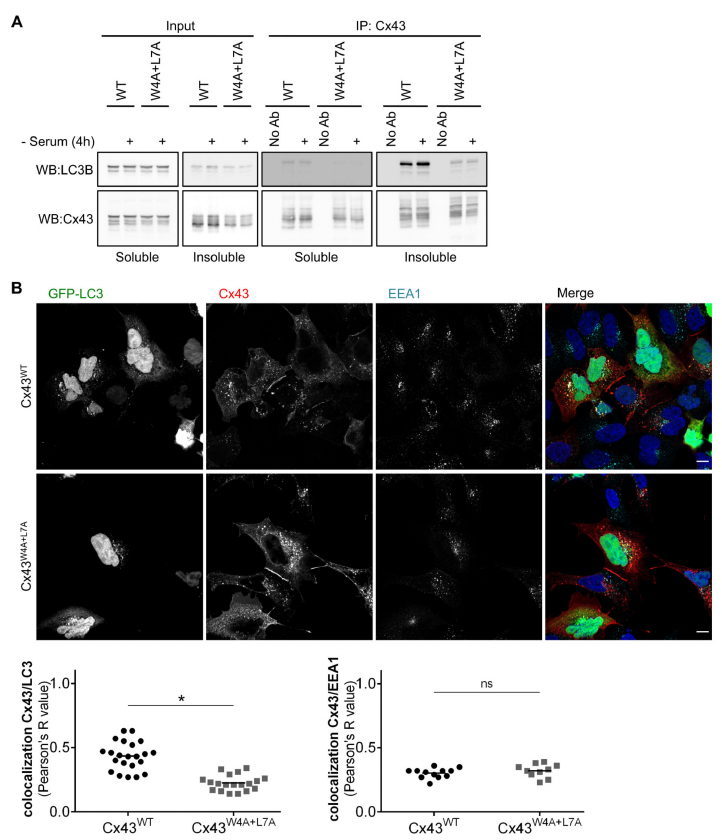
Figure 3. LC3B preferentially interacts with Cx43 present in post-endocytic vesicles. ( A ) HEK293A cells co-transfected with GFP-LC3B and wild type (WT) or mutant (W4A + L7A) Cx43 were incubated in medium without serum for 4 h (-Serum). Cell lysates were then separated into Triton X-100 soluble and insoluble fractions and immunoprecipitated with goat polyclonal antibodies directed against Cx43. Precipitates were then analysed using Western blot using rabbit polyclonal antibodies against Cx43 or LC3B. ( B ) HEK293A cells grown on coverslips were co-transfected with plasmids expressing GFP-LC3B and either Cx43 WT or Cx43 W4A + L7A . Subcellular distribution of the proteins was evaluated using confocal microscopy, and co-localization of Cx43 (red) with GFP-LC3B (green) or EEA1 (cyan) was quantified and plotted in a graph. Scale bars, 10 µ m. Dots represent values obtained for individual images (n = 4). * p < 0.05 using the Mann-Whitney